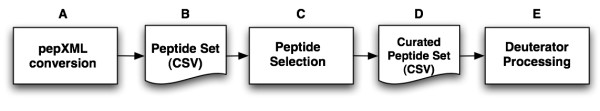
Peptide Set Process. A. The search results pepXML file is converted to CSV format to facilitate editing. B. The raw peptide set in CSV format. C. The user selects the peptides of interest. D. The final curated peptide set in CSV format. E. Deuterator processing.